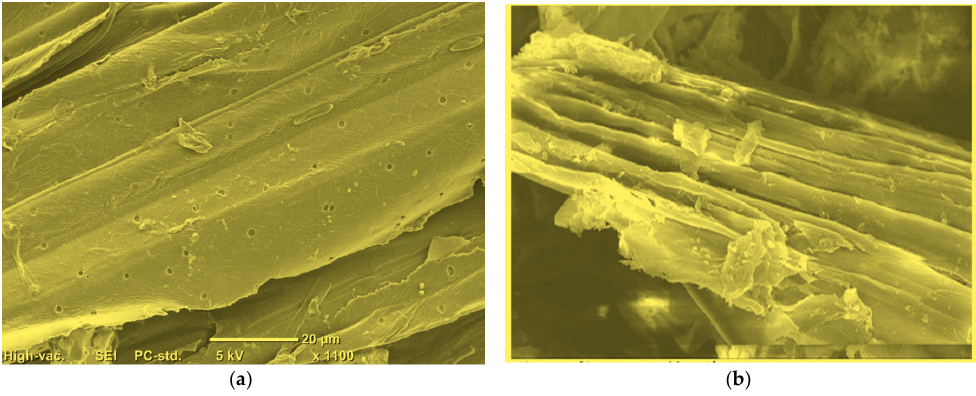
Figure 3. Bagasse structure before ( a ) and after acid (3%) and ultrasound pretreatment ( b ).